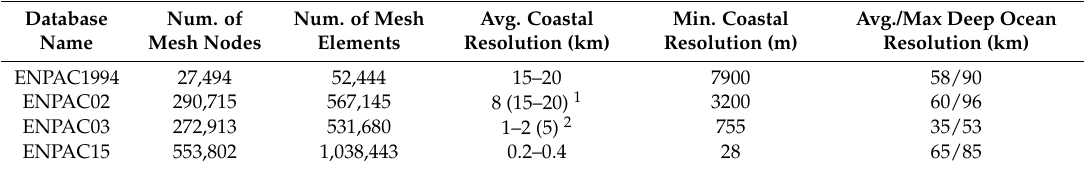
Table 1. Summary of grid features for Eastern North Pacific domain ADCIRC tidal